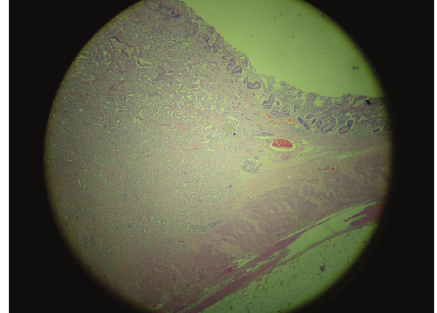
Figure 1: Carcinoid neuroendocrine tumor, stage 1, with infiltration to the subserosal layer, associated with autoimmune atrophic gastri- tis.